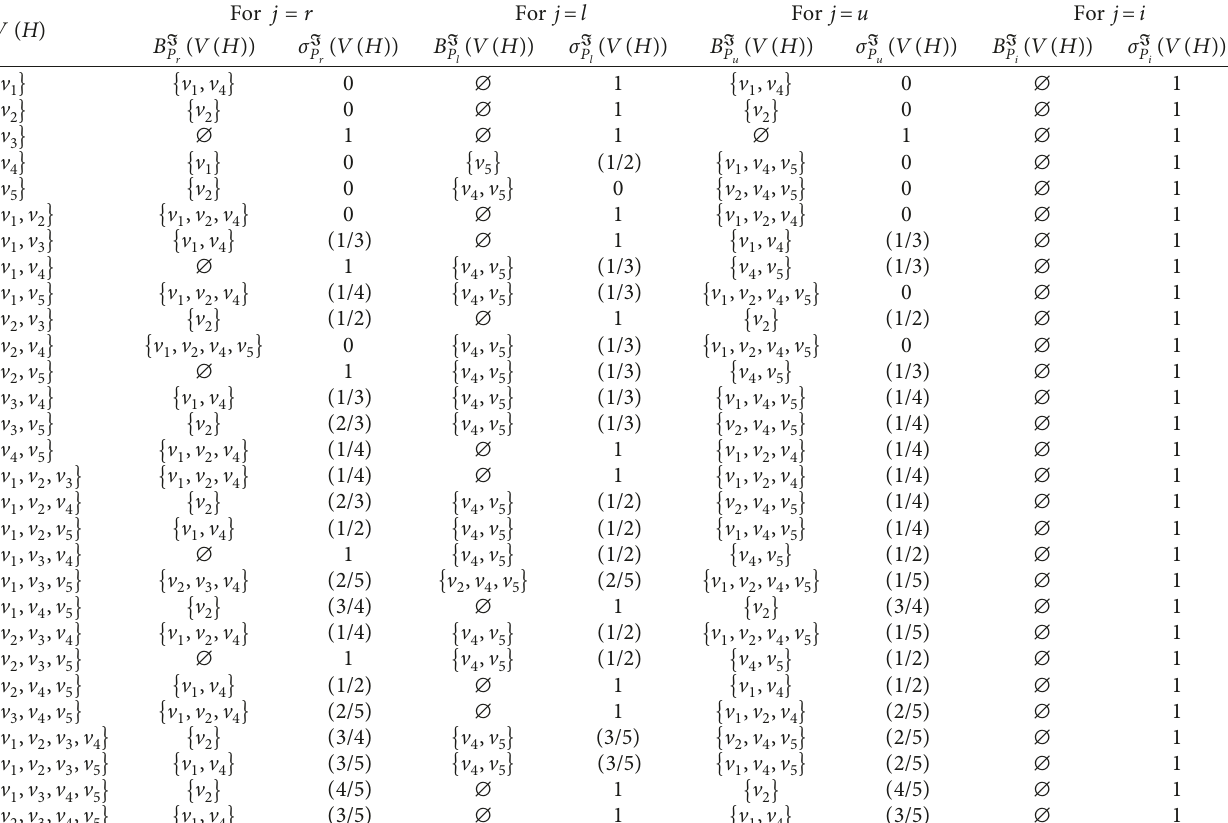
Table 2: Comparisons between the j -boundary and j -accuracy measures by using our approach for j � r,l, u,i { } .